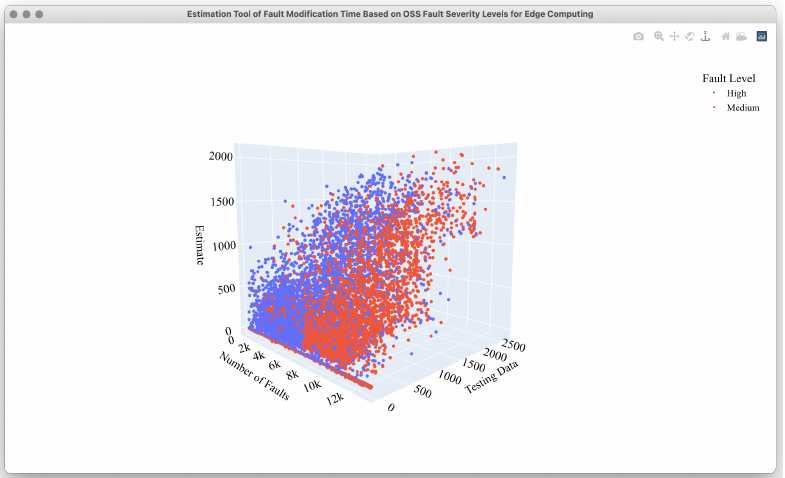
Figure 14. Another angle of the estimated fault correction time in case of 30% testing